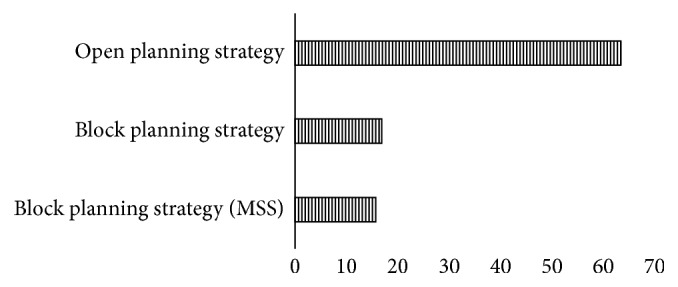
Planning strategies.